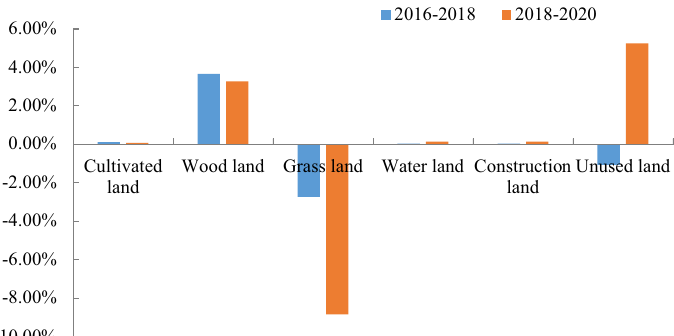
Figure 4. Changes in various landscapes (land use types) along the highway in 2016–2018 and 2018–2020.